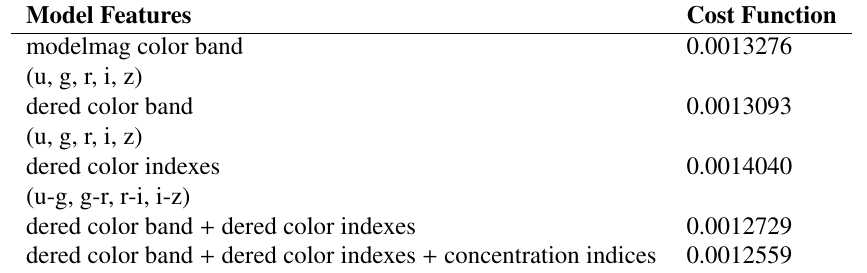
Table 1. Cost Function of Neural Networks with various